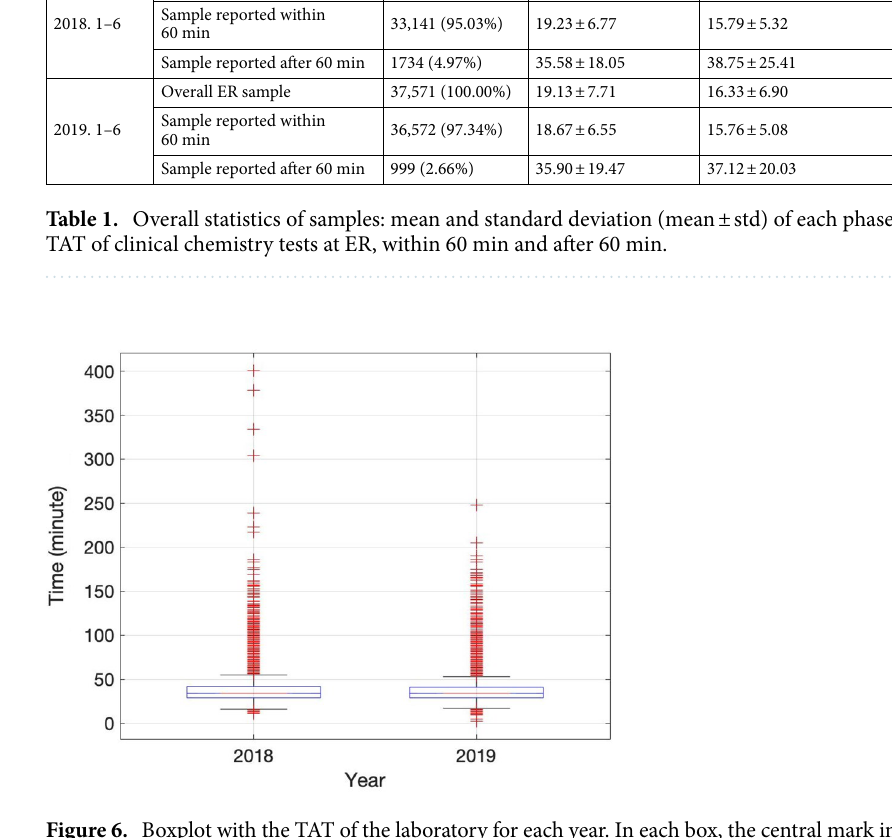
Figure 6. Boxplot with the TAT of the laboratory for each year. In each box, the central mark indicates the median, and the bottom and top edges of the box indicate the 25th and 75th percentiles, respectively. The outliers are plotted individually using the ‘+’